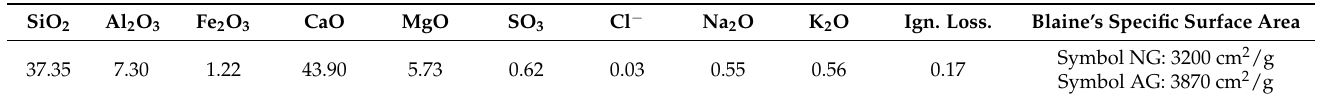
Table 1. Chemical composition of GGBFS, mass